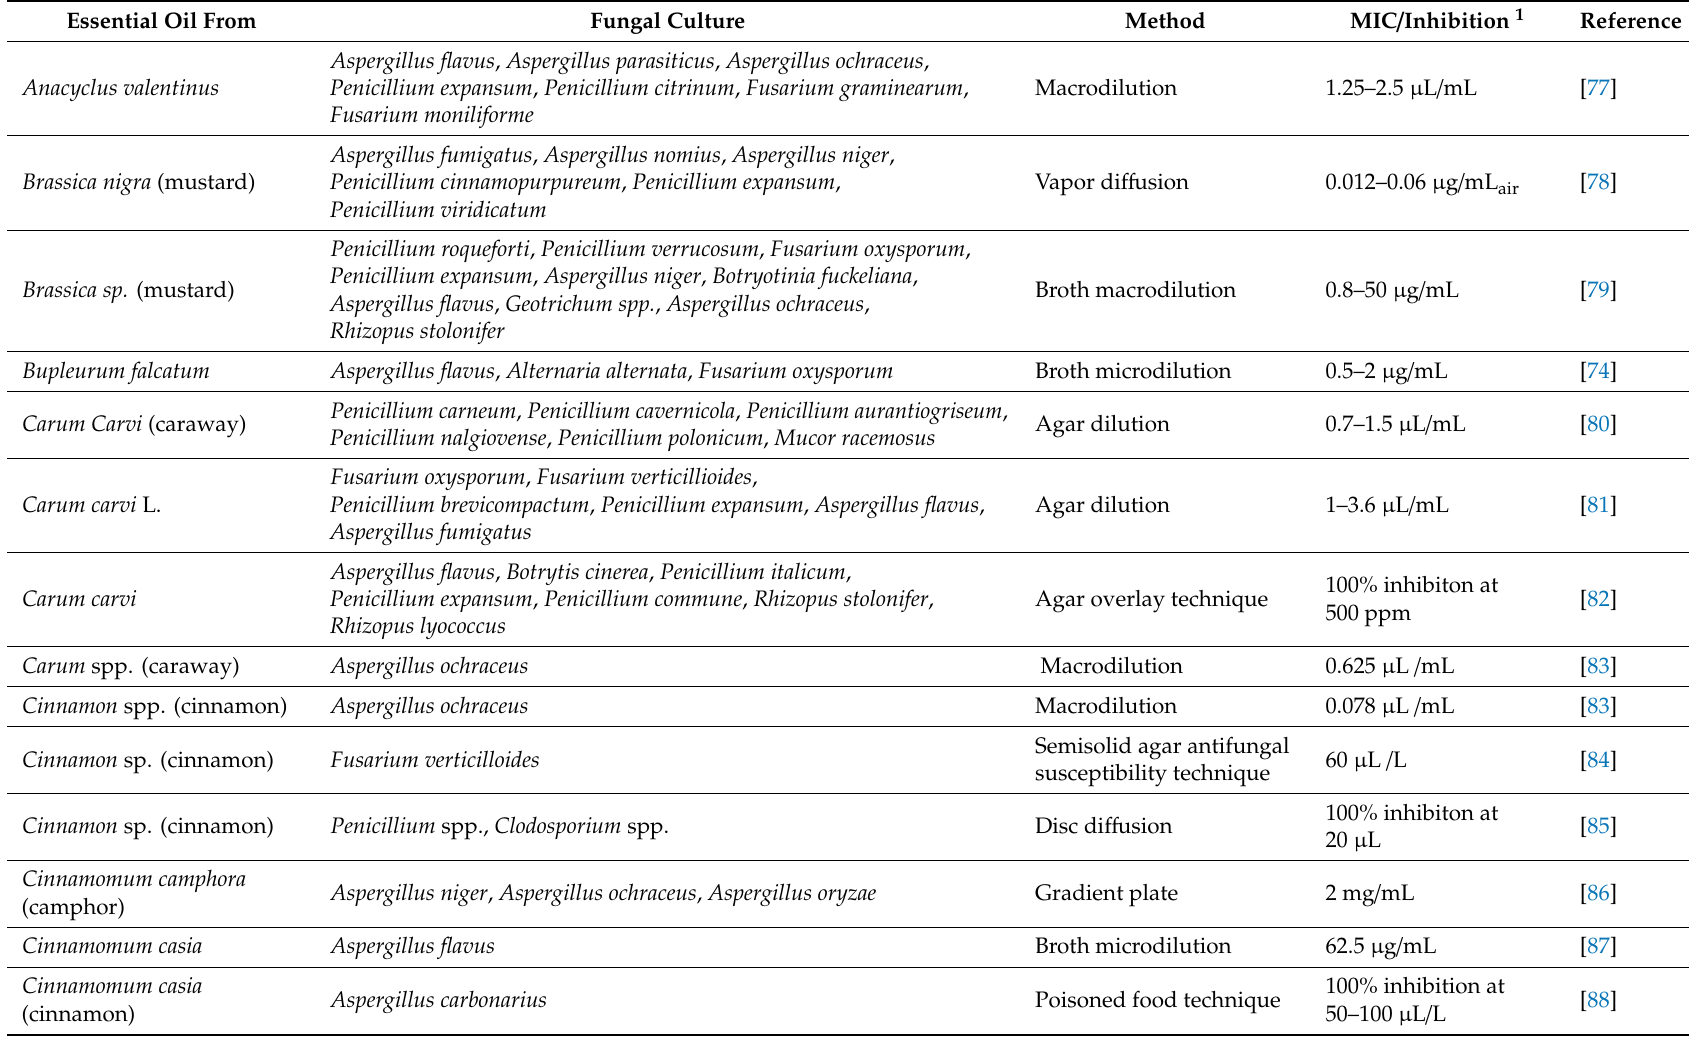
Table 2. Overview of studies about antifungal properties of essential